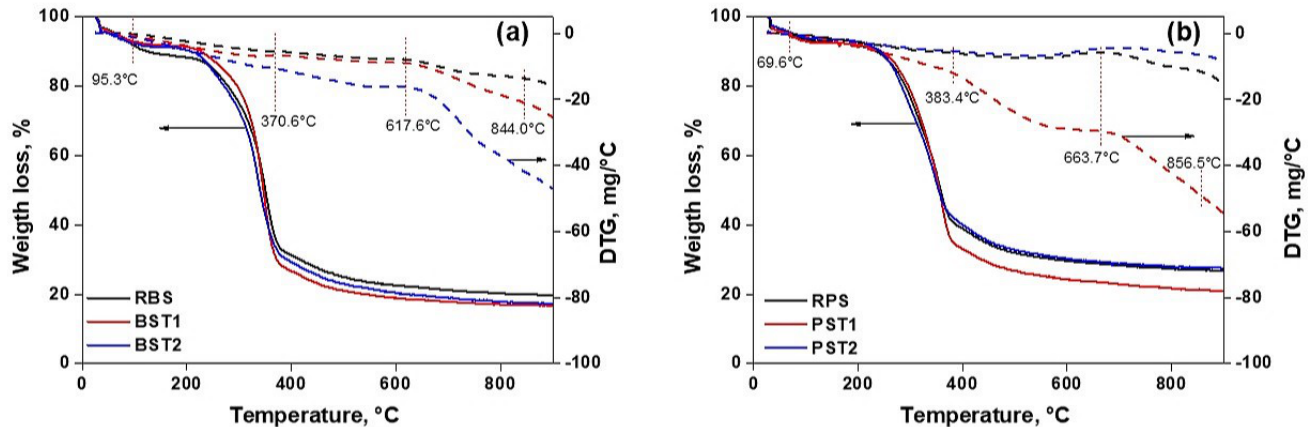
Figure 4. TG-DTG curves of bean pods ( a ) and pistachio pods ( b ): RBS and RPS (black curve), BST1 and PST1 (red curve), and BST2 and PST2 (blue curve). The dotted curves are those of the differential thermogravimetric analysis (DTG) for each studied sample. These thermal analyses, in which the rate of change in weight of the material upon heating is plotted against temperature, are derivatives of TGA thermogravimetric